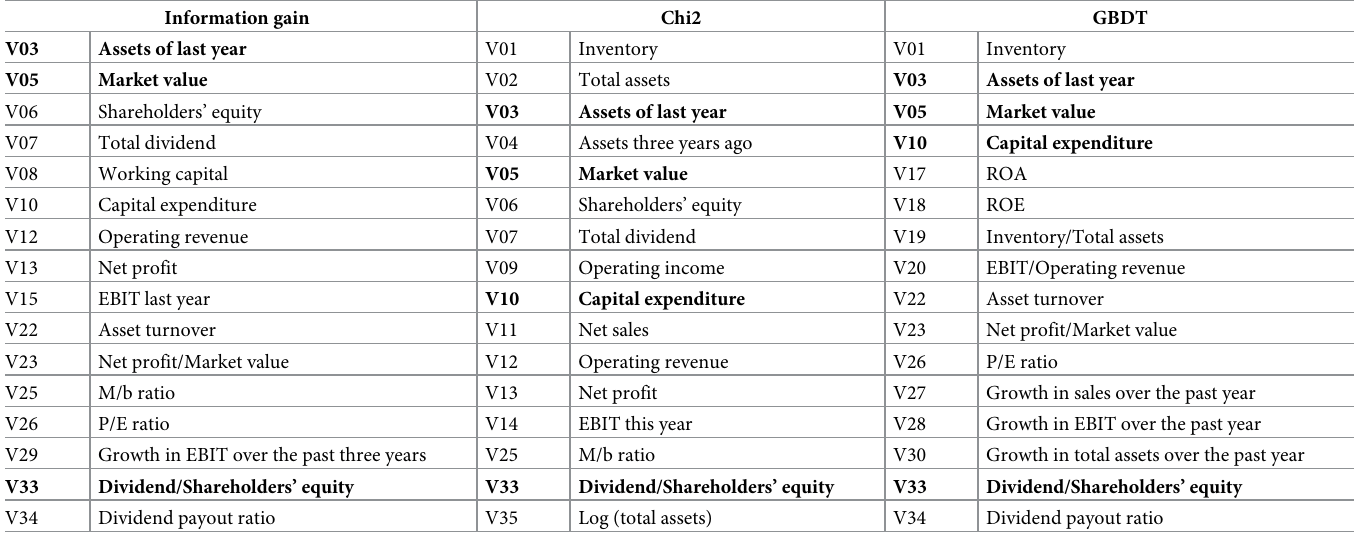
Table 3. Feature selection results.